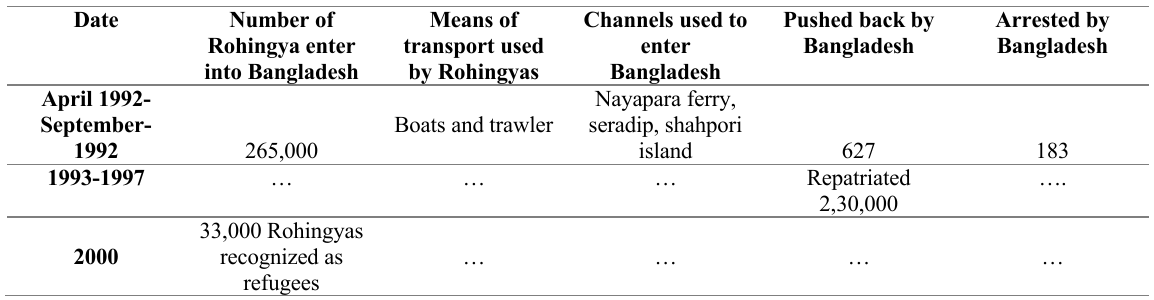
Table 2: A Report of Bangladesh’s Push Back Policy (April 1992 -September 2000)